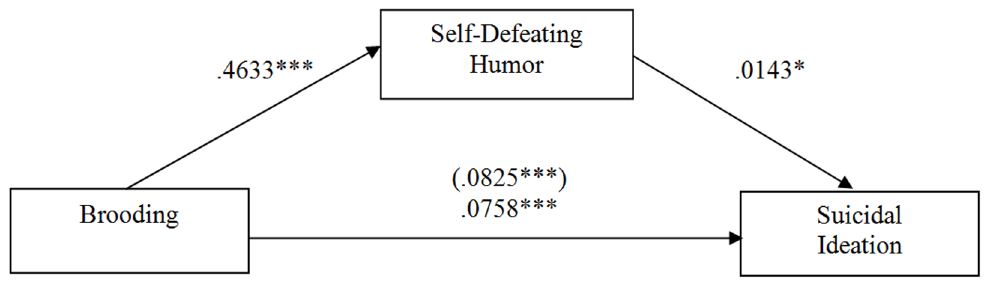
Figure 2. Model of the Indirect Effect of Brooding on Suicidal Ideation through Self-Defeating Humor. Note. Numerical values are the unstandardized regression coefficients and the number in parentheses represents the unmediated path.